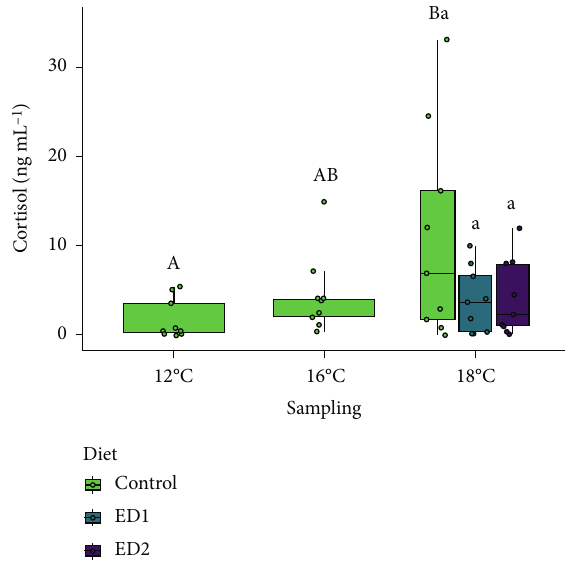
Figure 3: Basal (resting) plasma cortisol concentrations over the course of the study ( n = 9 per each sampling/dietary treatment). Upper case letters denote signi fi cant ( p < 0 : 05 ) di ff erences between samplings within the control treatment. Lower case letters indicate that no di ff erences were detected among dietary treatments at 18 °